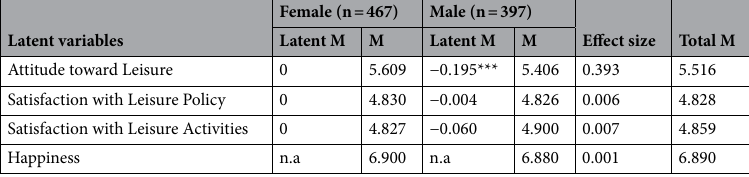
Table 4. Results of latent mean analysis. The latent mean values for females were fixed to zero. *** p < 0.001.